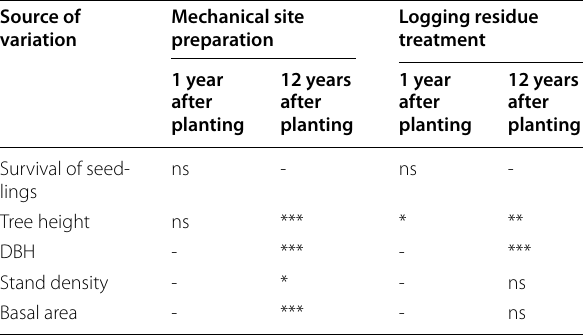
Table 3 Results of ANOVA, presenting the p values for the effects of mechanical site preparation and logging residue treatment on seedling survival, DBH (diameter at breast height), tree height, basal area, and stand density of sampled Scots